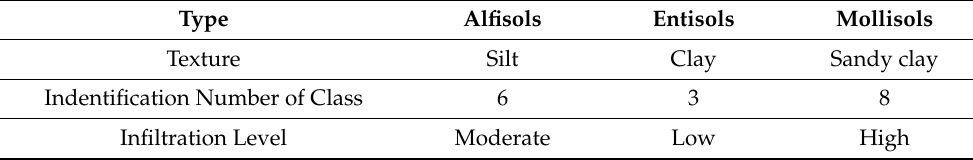
Table 3. Soil texture and corresponding class of infiltration